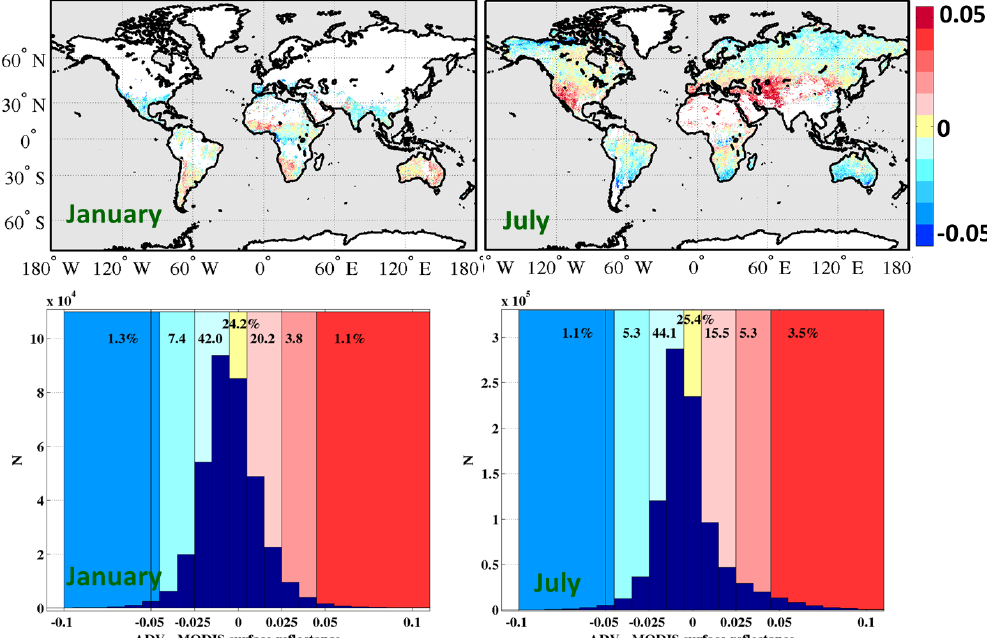
Figure 10. Monthly aggregated maps (upper panel) and histograms (lower panel) of the differences between ADV-retrieved and MODIS- derived surface reflectances at 555nm for January (left) and July (right). Numbers in the histogram bins (colored in blue, yellow and red) at the top of the histograms are the percentages of hits of the differences to bins.